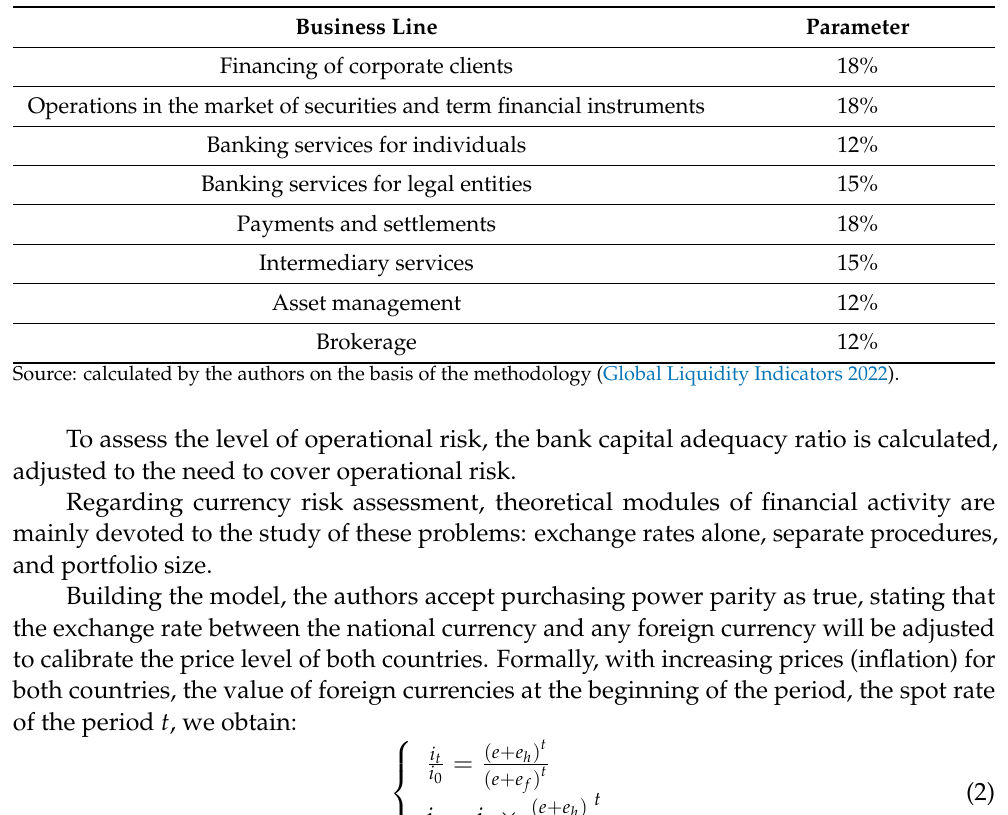
Table 1. The value of β -coefficient (Global Liquidity Indicators